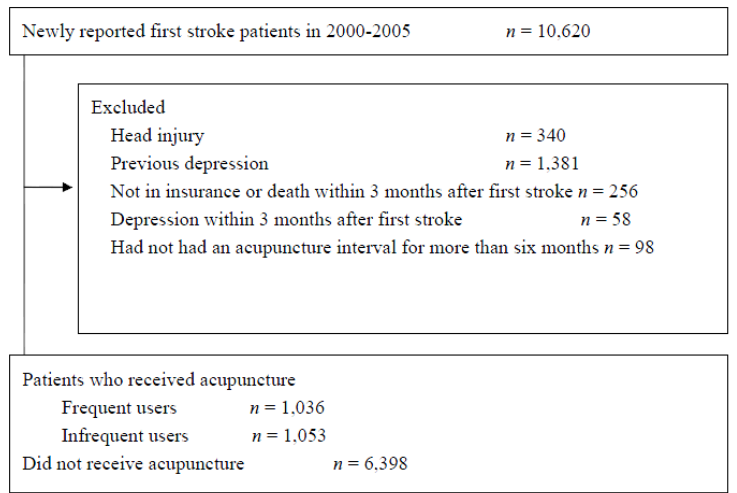
Figure 1. Flow chart showing details of subject recruitment from the National Health Insurance Research Dataset (NHIRD) of Taiwan for the years 2000 to